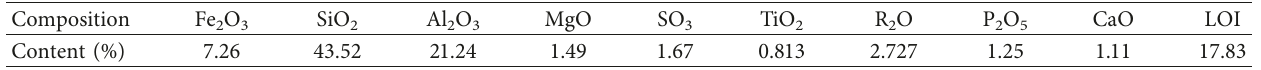
Table 2: Chemical compositions of dried dredged sludge.